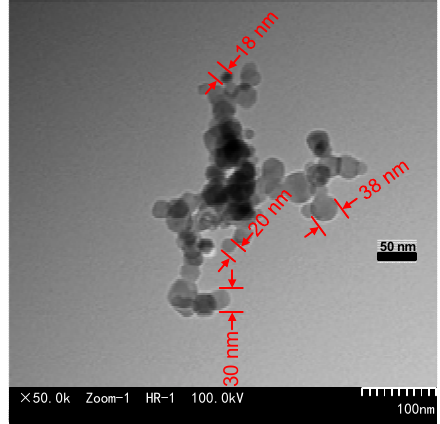
Figure 5. TEM image of the nano-C 60 particles.